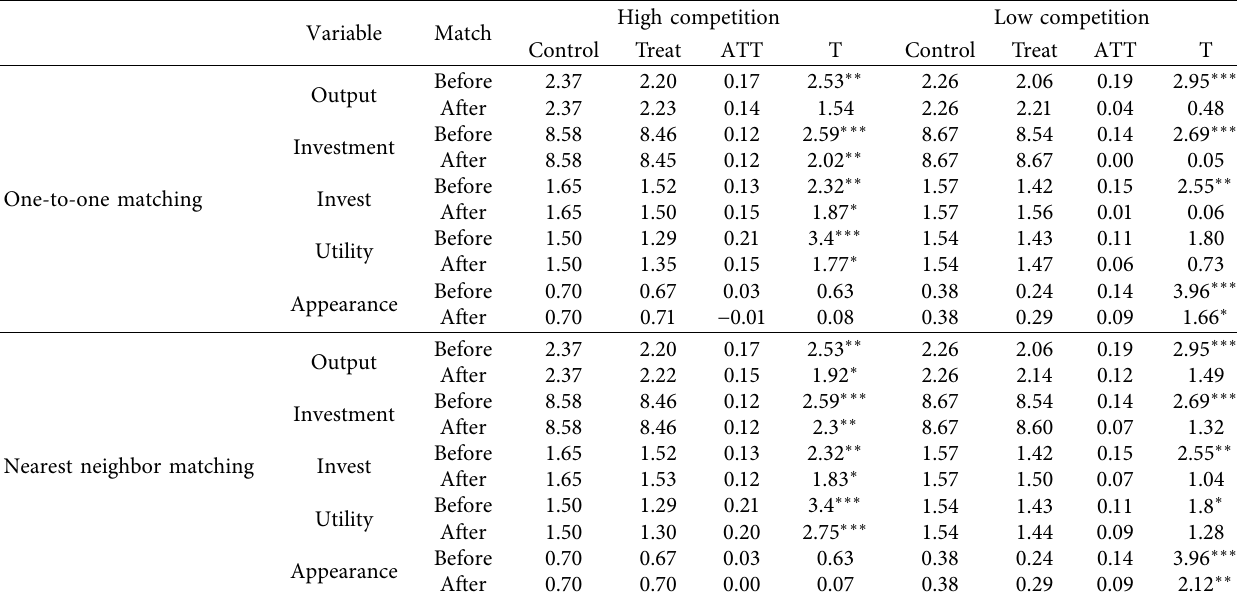
Table 7: Policy incentive effects under different market competition levels. High competition Low competition Variable Match Control Treat T